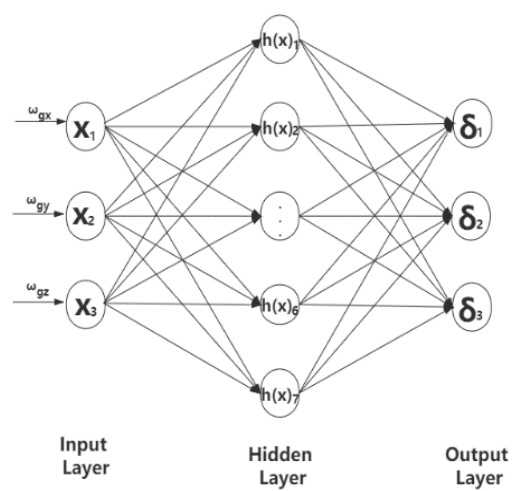
Figure 3. MIMO RBF neural network structure.